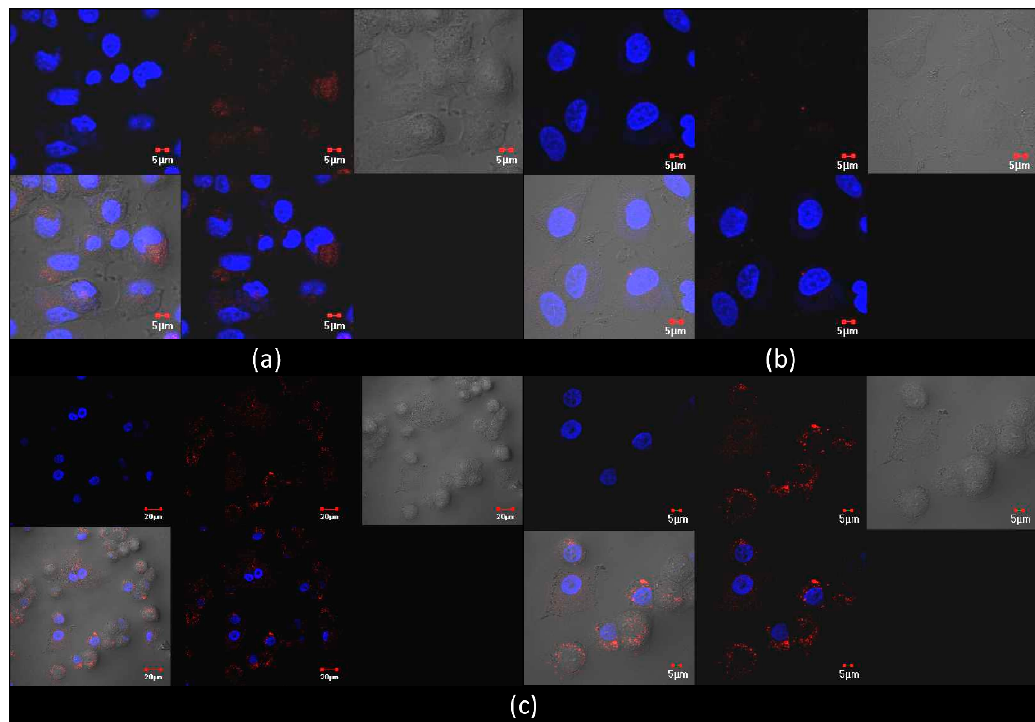
Figure 8. Internalization of polyplexes based on ZS-371-3 ( a ) and ZS-371-5 ( b , c ) polymers in A549 cancer cells after 4 ( a , b ) and 6 ( c ) h observed using laser scanning confocal microscopy. Scale bar represents 5 ( a – c , right) and 25 ( c , left) µm.